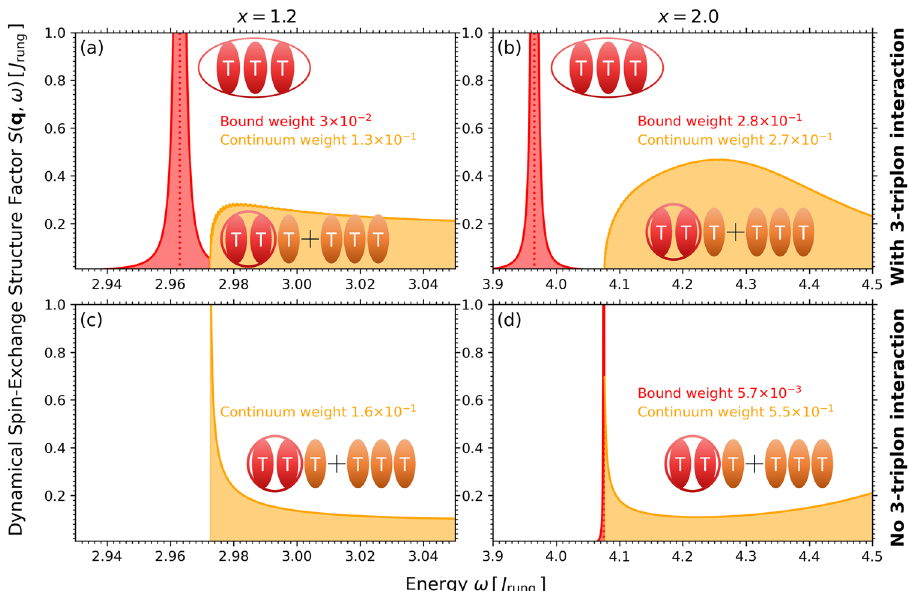
Fig. 3 RIXS response in the S = 0 channel for ( q x , q y ) = ( π /(2 a ), π / a ). The groups of three ellipses with the letter ‘ T ’ denote three-triplon states. Asymptotically scattering triplons are colored orange and bound triplons are colored red. a , b Result from the mixed deepCUT calculations: (2: n )-generator in order 10 for the single- and two-triplon matrix elements, (3: n )-generator in order ≥ 5 for the three-triplon matrix elements (see Supplementary Methods). The effective observable was computed with the (3: n ) generator. c , d Results from the (2: n ) deepCUT calculations in order 10 excluding irreducible three-triplon interactions. a , c Depict a system with x = 1.2; panels b and d with x =